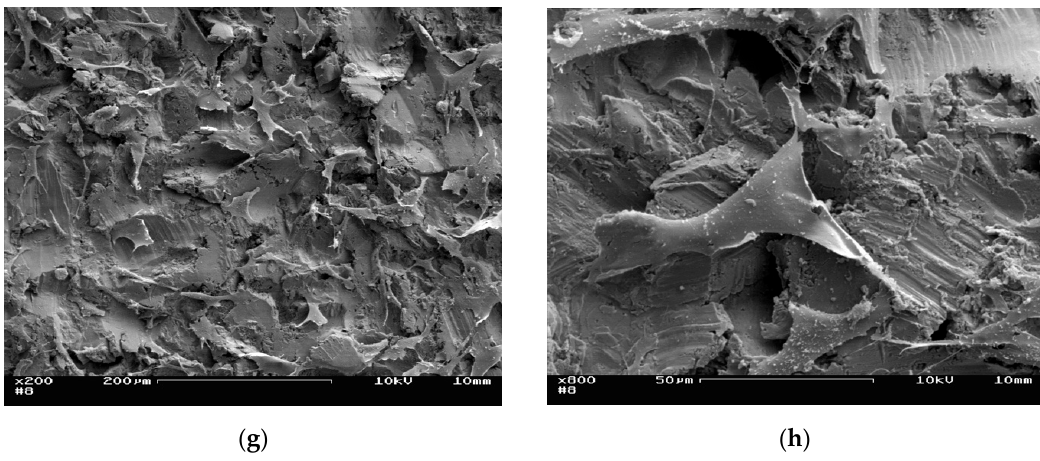
Figure 4. SEM images of cell seeded surfaces. On all shown pictures, primary human osteoblasts were cultivated for three days under standard conditions. Reference material ( a ) 200 k and ( b ) 725 k (magnification). Cast specimens ( c ) 200 k and ( d ) 625 k (magnification). Cast specimens with ion beam implantation of Ca (ion density 1 × 10 − 16 cm 2 , energy level 30 keV) (( e ) 200 k and ( f ) 800 k magnification). Cast discs with ion beam implantation of P (ion density 1 × 10 − 16 cm 2 , energy level 30 keV) (( g ) 200 k and ( h ) 800 k magnification). Scanning electron microscopy was performed using a Hitachi S-5200 (Tokyo, Japan). Pictures were taken from [18] with permission.